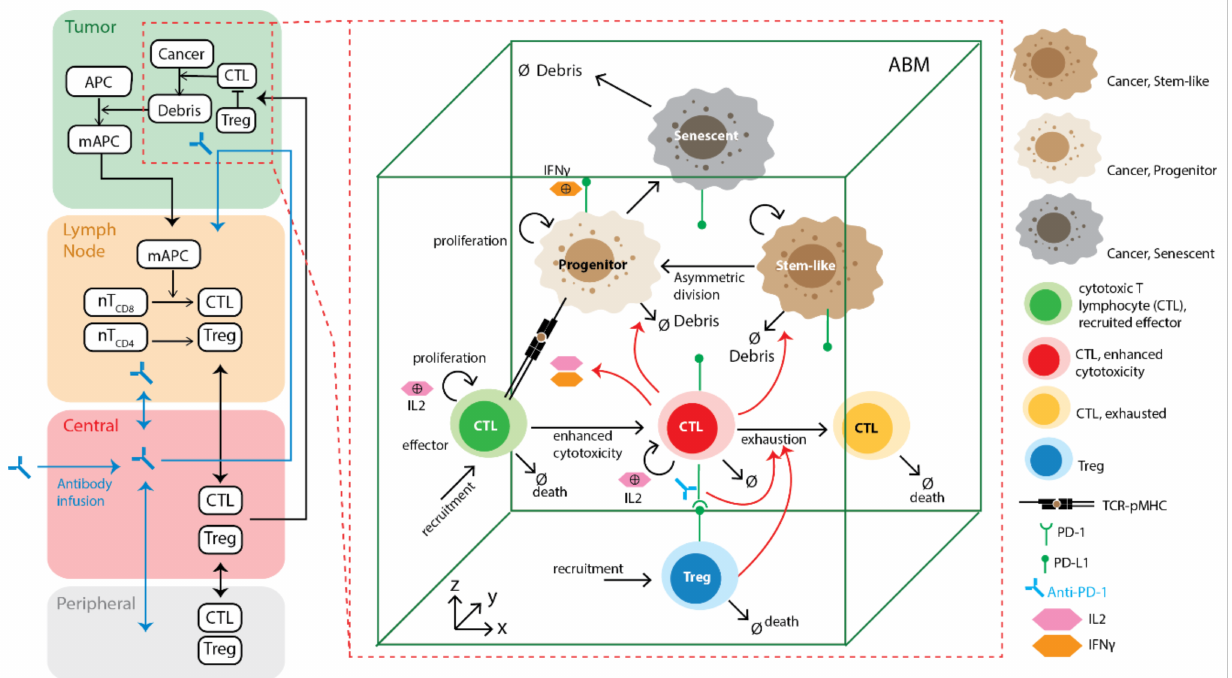
Figure 1. Transport and interaction of cells and molecules in different compartments. On the left: QSP model: central compartment, tumor-draining lymph node compartment, peripheral compartment, and tumor compartment are included in the model. Mature antigen-presenting cells process tumor antigen collected in the tumor compartment and transport them through lymphatic vessels to the lymph node compartment to prime naïve cytotoxic T lymphocytes (CTL) and T regulatory cell (Treg). After clone expansion, these cells are trafficked through blood circulation (central compartment) and extravasate into the tumor microenvironment. On the right: spatio-temporal ABM module partially replaces the tumor compartment from the QSP model, capturing dynamics of different subtypes of cancer cells and T cells and their interactions with higher granularity and a spatial resolution. Spatio-temporal distribution of soluble cytokines IL-2 and IFN γ are described by PDEs. Details of these interactions are described in the method